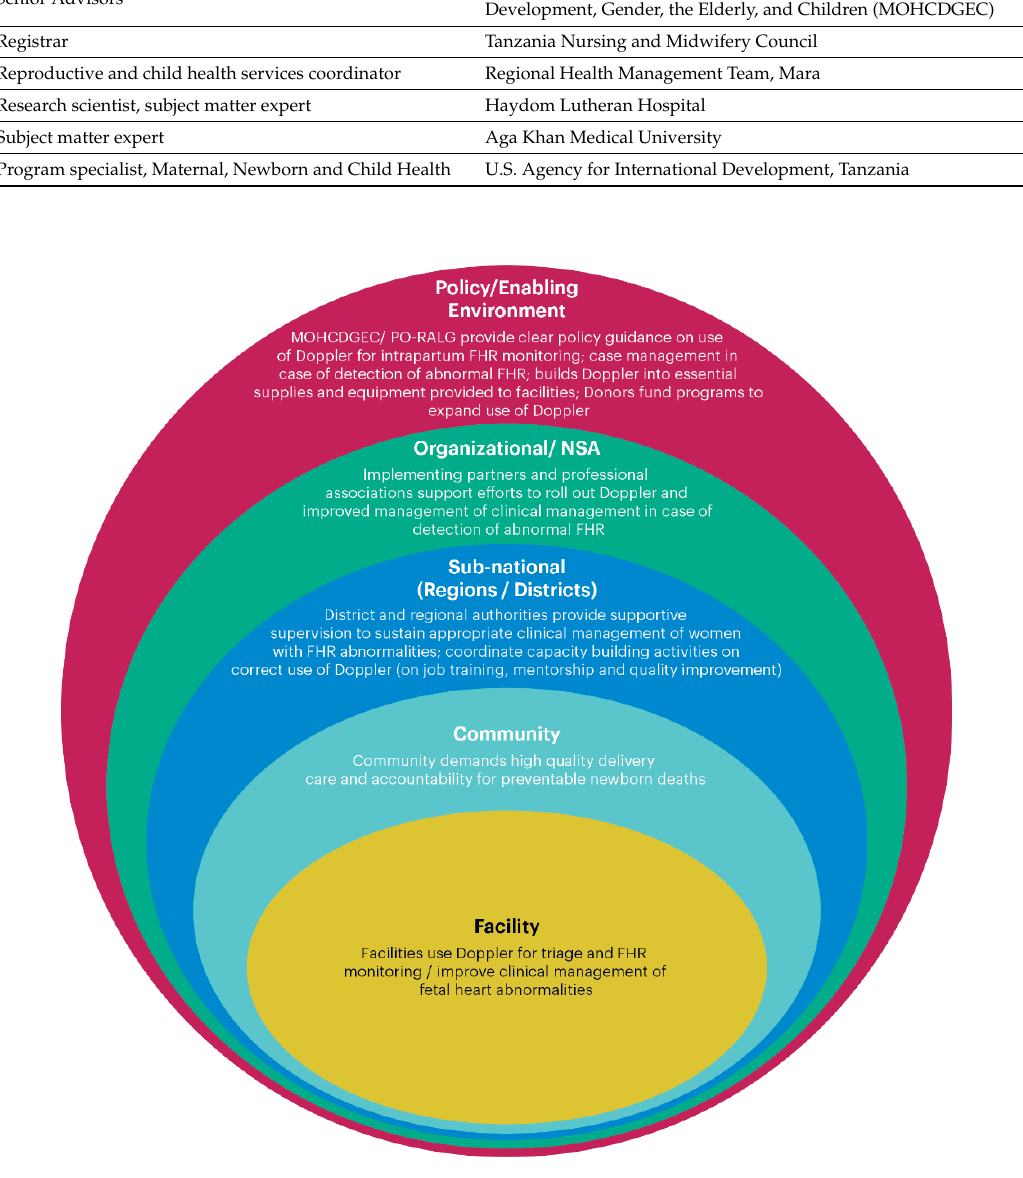
Figure 1. Social ecological framework: needs associated with every environmental level for scale-up of Doppler. NSA: Non-state actors.